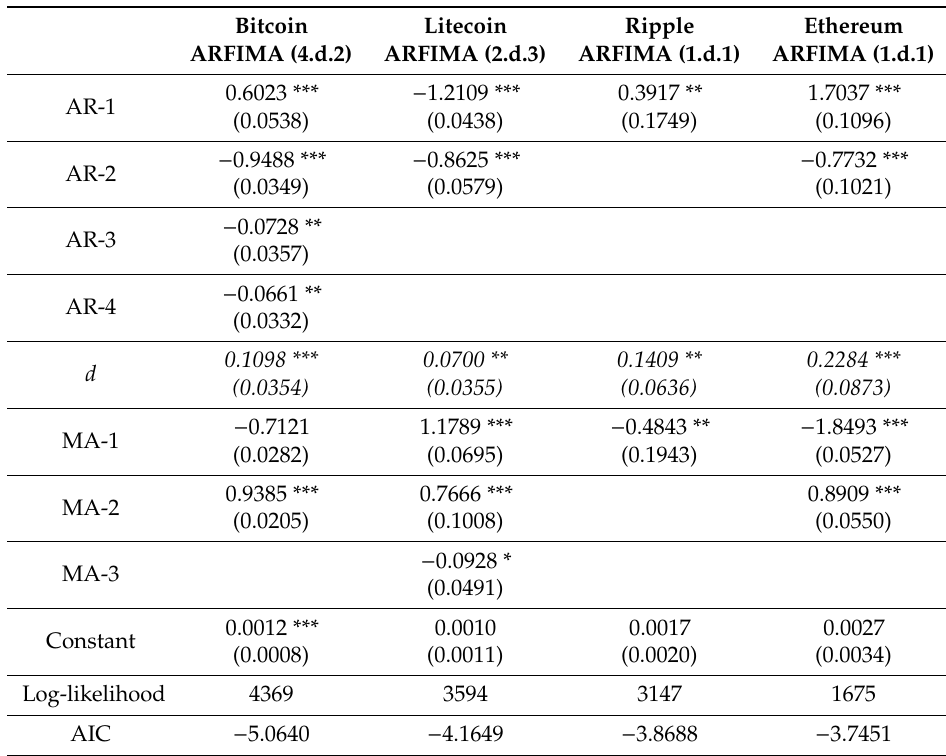
Table 4. ARFIMA model